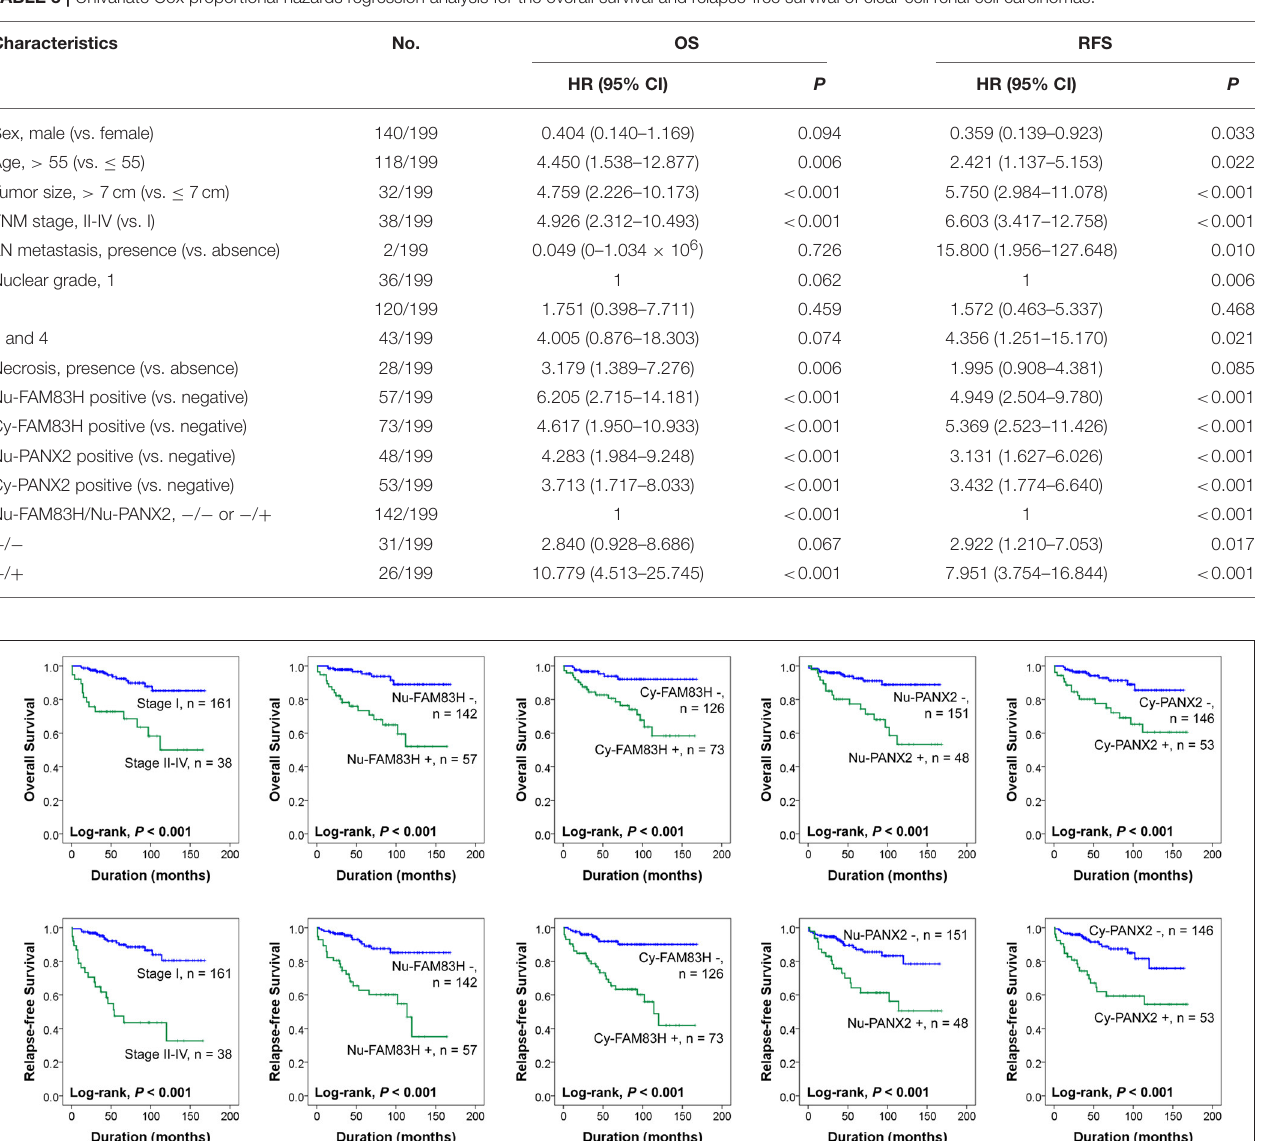
Log-rank, P < 0.001, RFS; Log-rank, P < 0.001) are presented in Figure 2 . ( Table 4 ). Tumor stage ( P < 0.001), Nu-FAM83H positivity ( P = 0.003), and Cy-FAM83H positivity ( P = 0.030) were the factors significantly associated with RFS of CCRCC patients